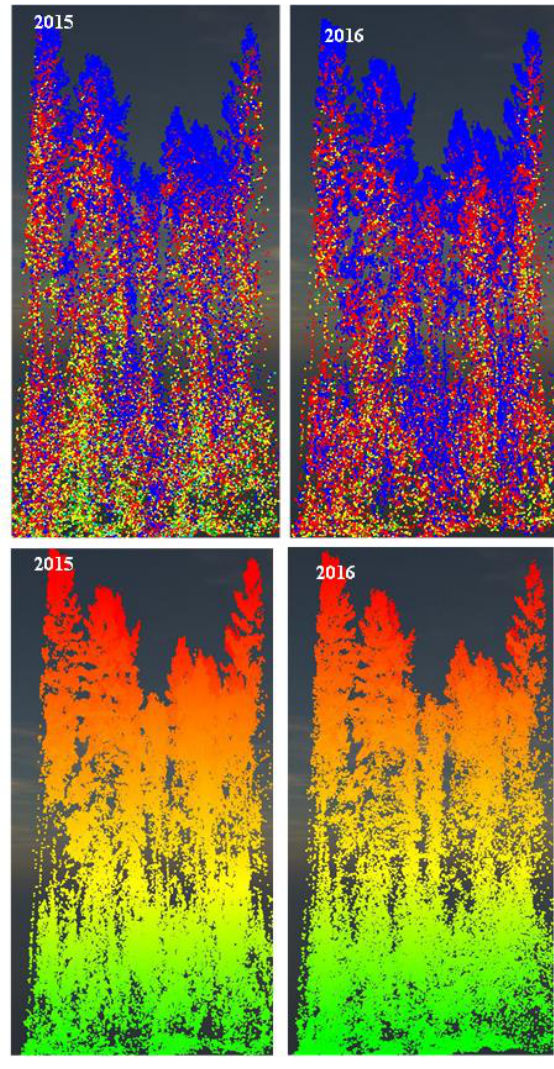
Figure 2. 3D lidar point distribution of a sample site. Top image shows multi return echoes (blue-1st, red – 2nd , yellow – 3rd, green – 4th returns); bottom image shows the gradient of vegetation height (green to